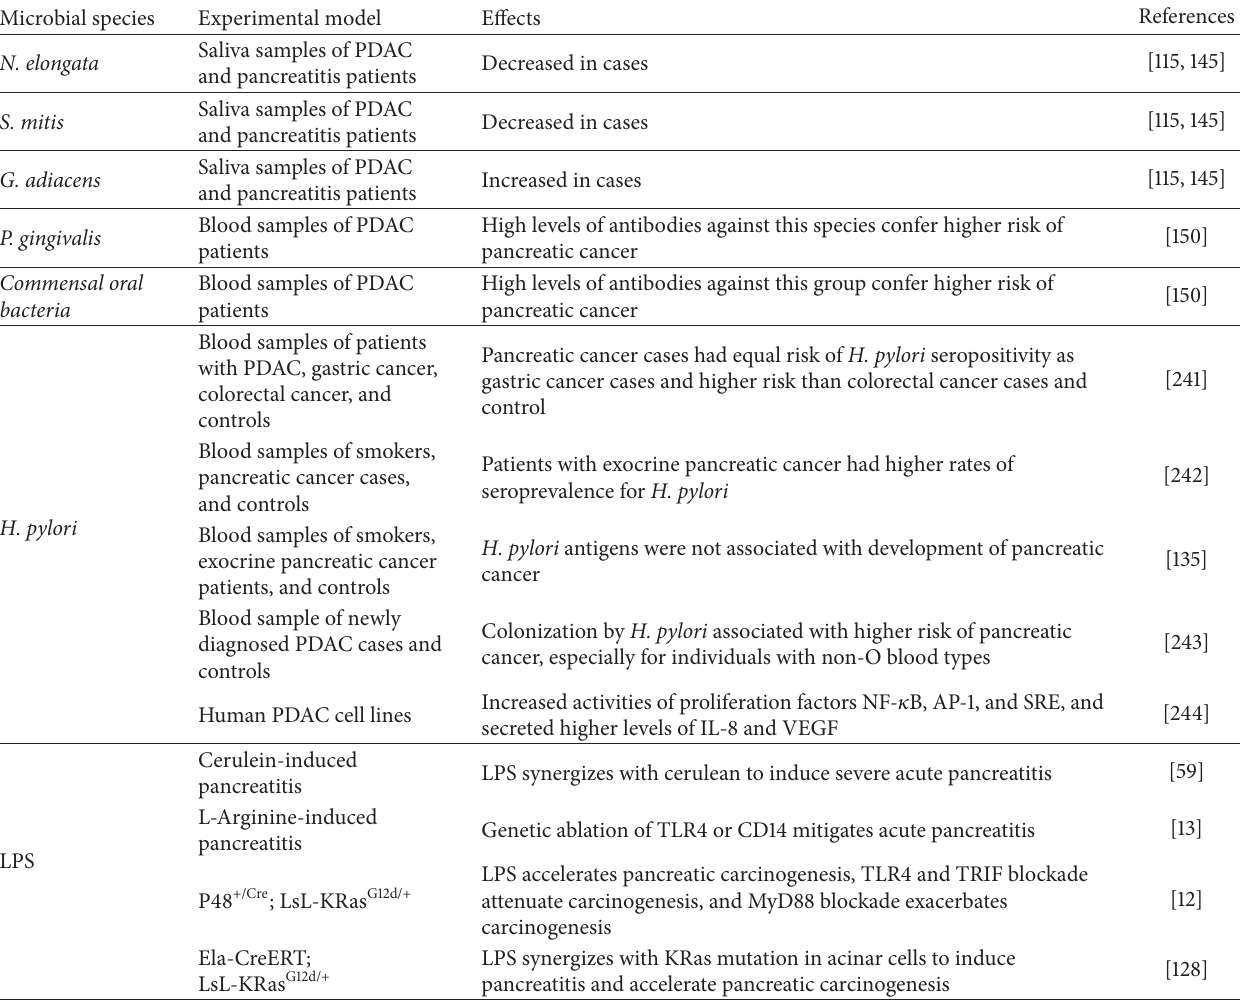
Table 2: Microbial species implicated in pancreatic cancer and pancreatitis. A current list of the characterized microbes is shown, which includes the experimental models that were evaluated and the observed effects according to each microbial species. The respective bibliographies are also listed (last